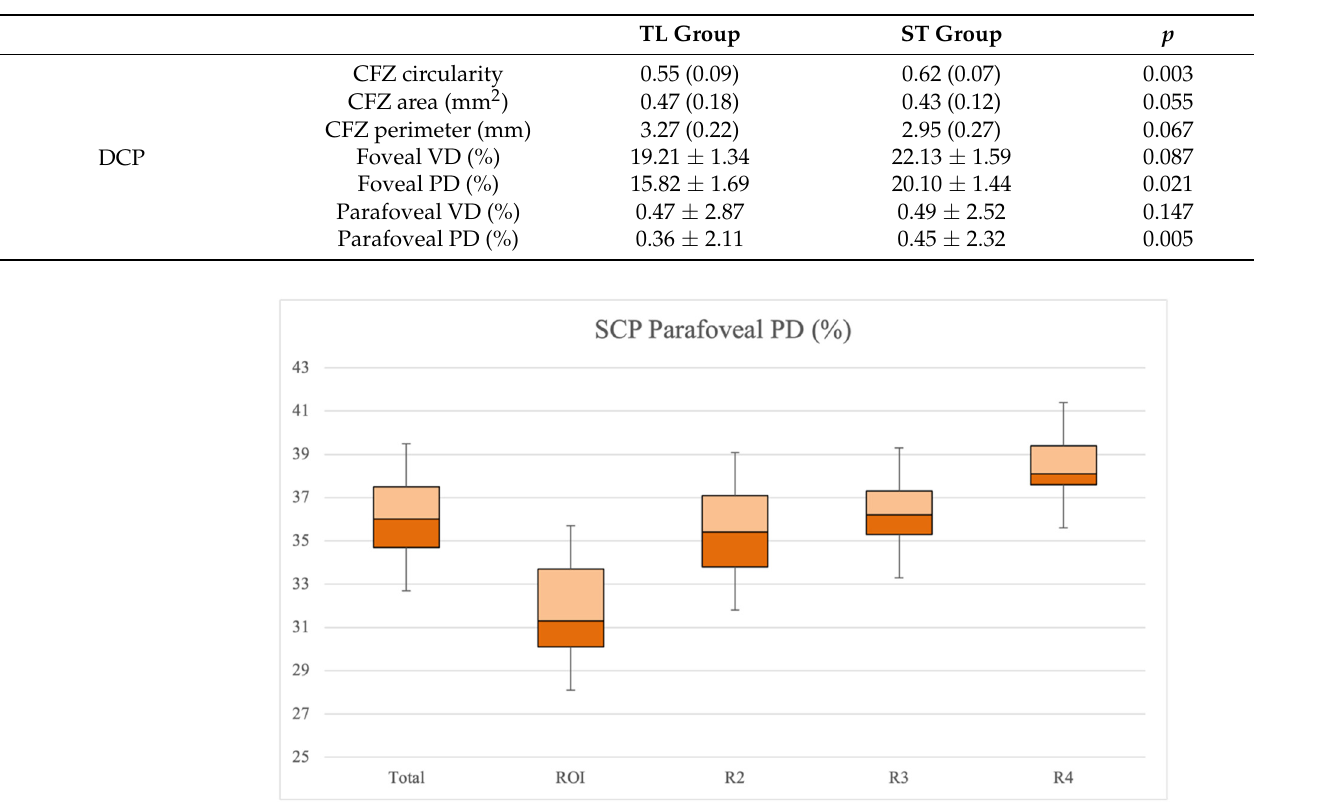
Figure 3. Representation of SCP parafoveal PD (%) in total parafoveal area, ROI and remaining regions in TL group. PD = perfusion density; ROI = region of interest; SCP = superficial capillary plexus; TL = tissue loss. Table 2. Comparison between the two study groups on the basis of OCT-B scan and OCT-A variables of interest. CFZ = capillary free zone; DCP = deep capillary plexus; EZ = ellipsoid zone; LHEP = lamellar hole-associated epiretinal prolifer- ation; PD = perfusion density; PVD = posterior vitreous detachment; SCP = superficial capillary plexus; ST = stable; TL = tissue loss; VD = vessel density.